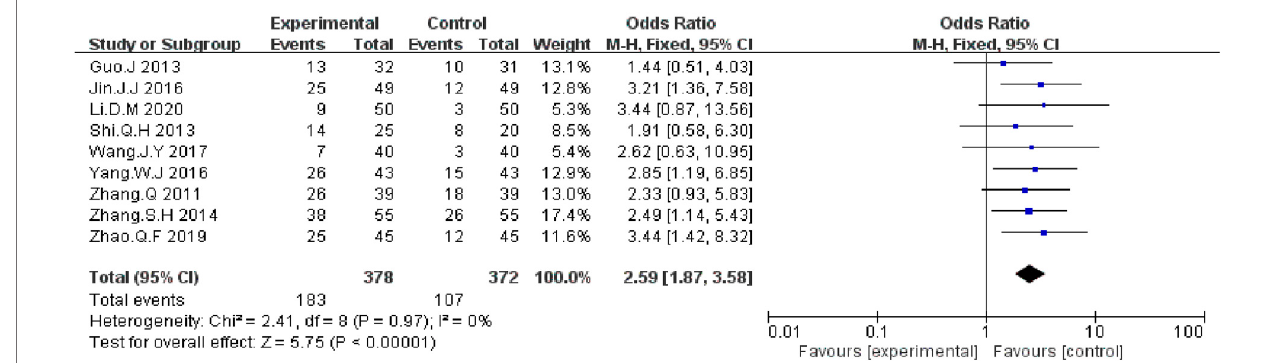
FIGURE 5 | Forest plot of ORR in patients treated with KLT + EGFR-TKI and EGFR-TKI alone.